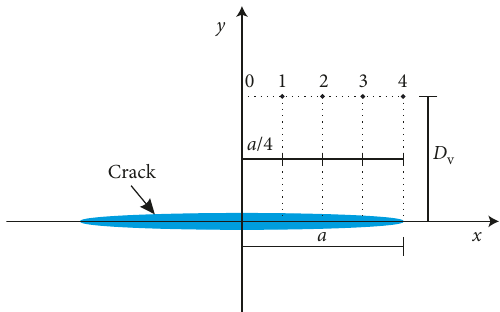
Figure 9: Schematic diagram of research points